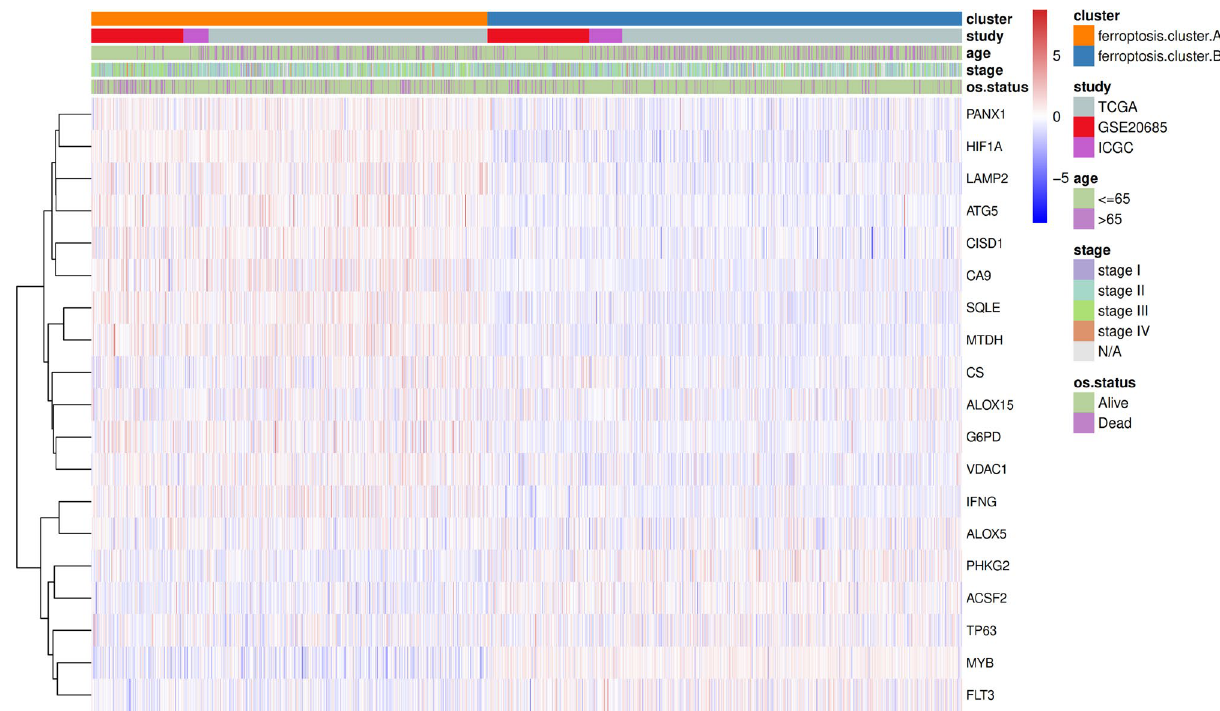
Figure 4. The expression of ferroptosis genes in ferroptosis